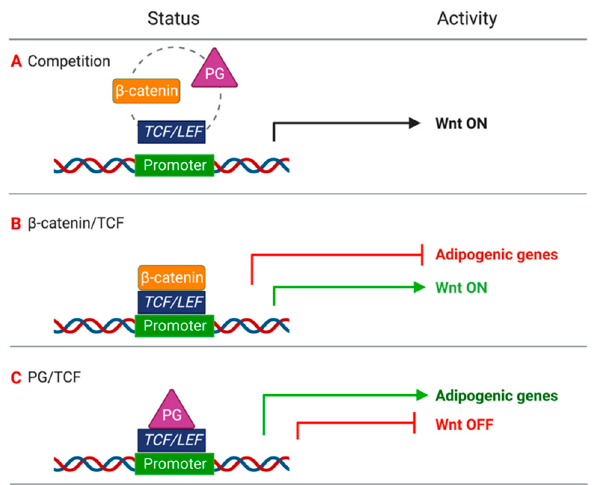
Figure 10. Competition of β -catenin and PG for TCF/LEF binding and relative activity. ( A ) β -catenin and PG compete for the binding to TCF/LEF; ( B ) when β -catenin/TCF binds to the promoter the transcription of adipogenic genes is inhibited; and ( C ) PG/TCF complex binds to the promoter of adipogenic genes and mediates their transcription.